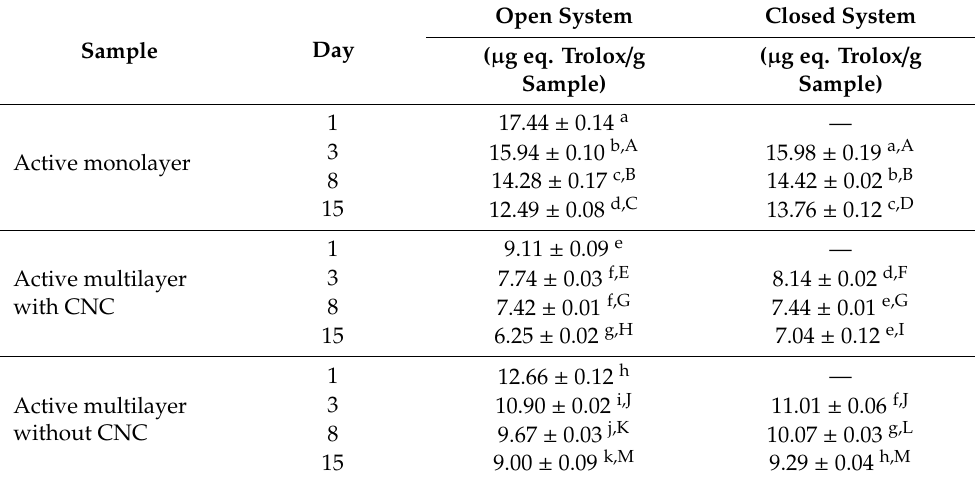
Table 6. Concentration ( µ g eq. Trolox / g sample) of 2,2-diphenyl-1-picrylhydrazyl radical (DPPH) of the active multilayer films with and without cellulose nanocrystal (CNC) coatings in the open a closed system for 15